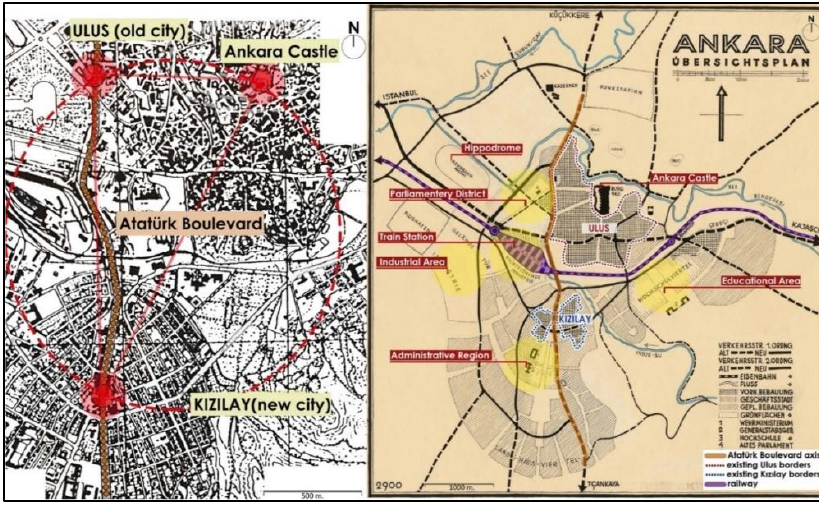
Figure 9 Jansen’s Planning Period (1928 -32) & spatial